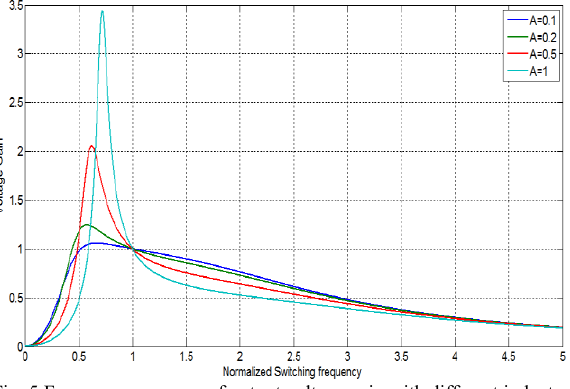
Fig. 5 Frequency response of output voltage gain with different inductor